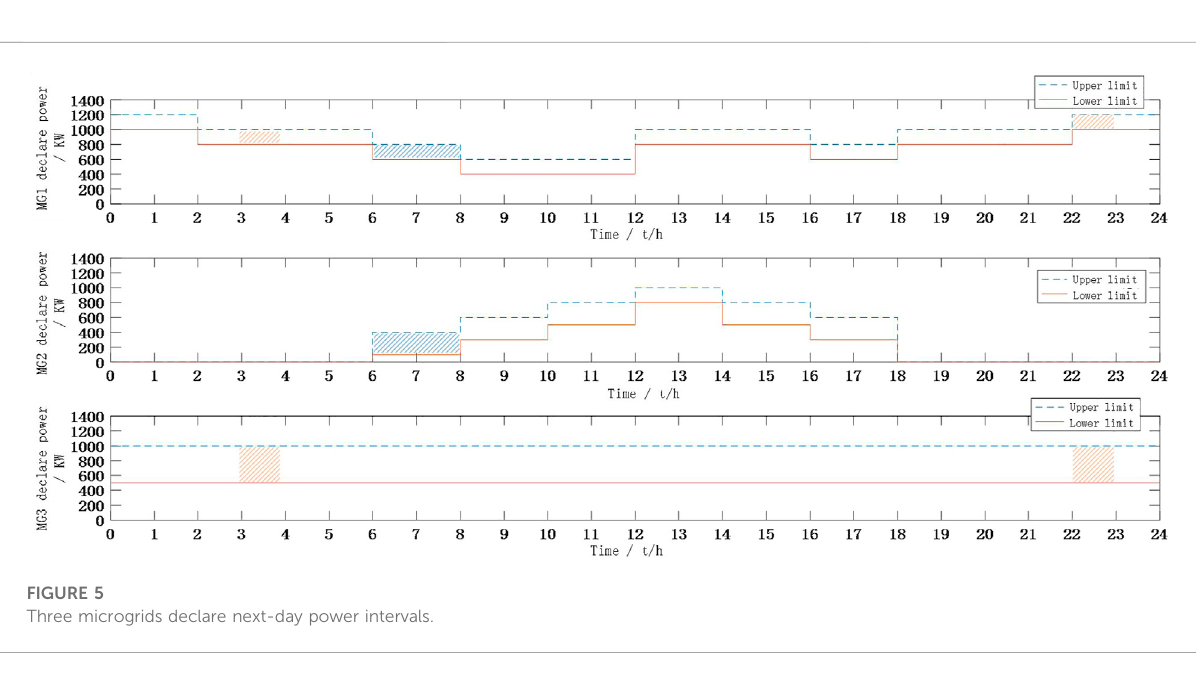
FIGURE 5 Three microgrids declare next-day power intervals.